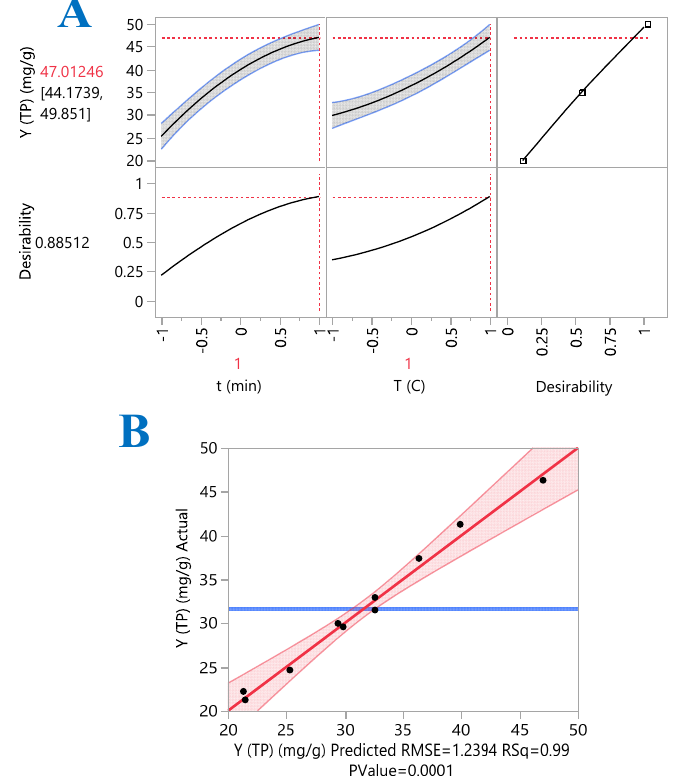
Figure 4. Statistical data on model fitting, accomplished with response surface methodology. ( A ) Desirability function showing optimal predicted values of both variables and maximum predicted Y TP ; ( B ) actual-by-predicted plot.